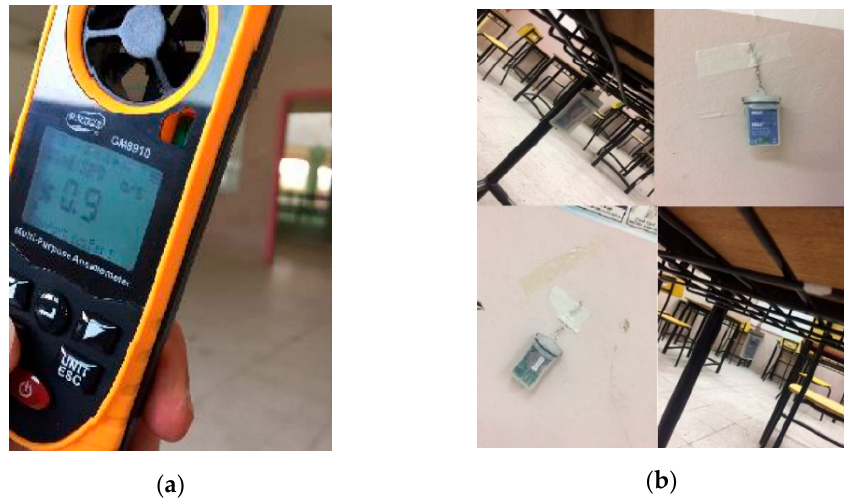
Figure 5. ( a ) Benetch anemometer for recording indoor classroom air speed and ( b ) temperature measurement with Hobo